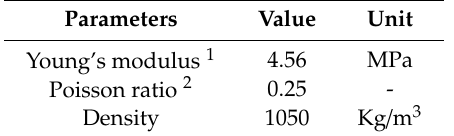
Table 1. Finite Element Modeling (FEM) parameters